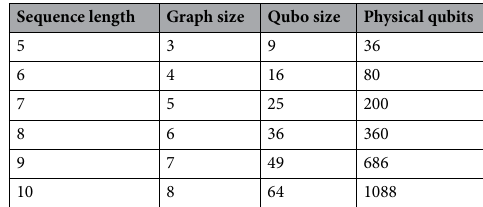
Table 2. Experimental scheme for the synthetic dataset.